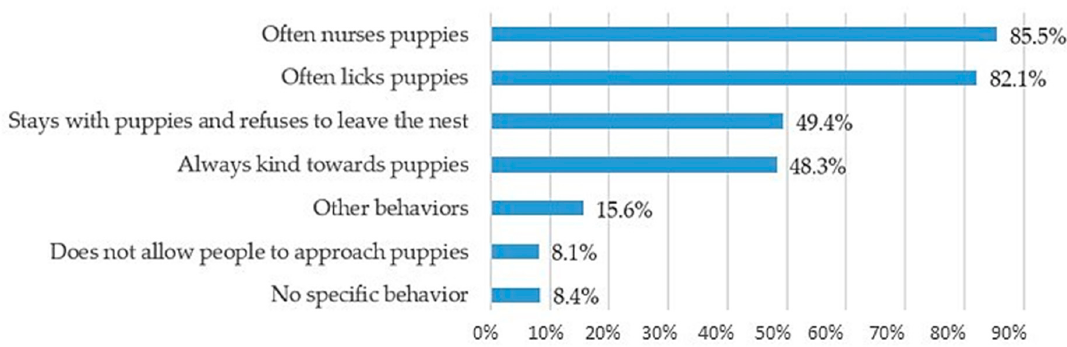
Figure 11. Signs of motherly attitude after puppies’ birth (multiple answers allowed).